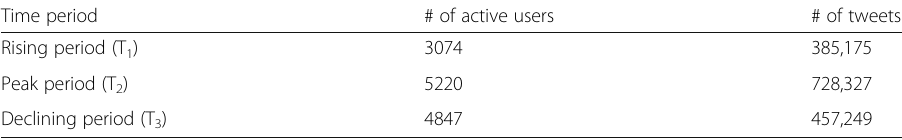
Table 1 Basic information (number of users and number of tweets) Time